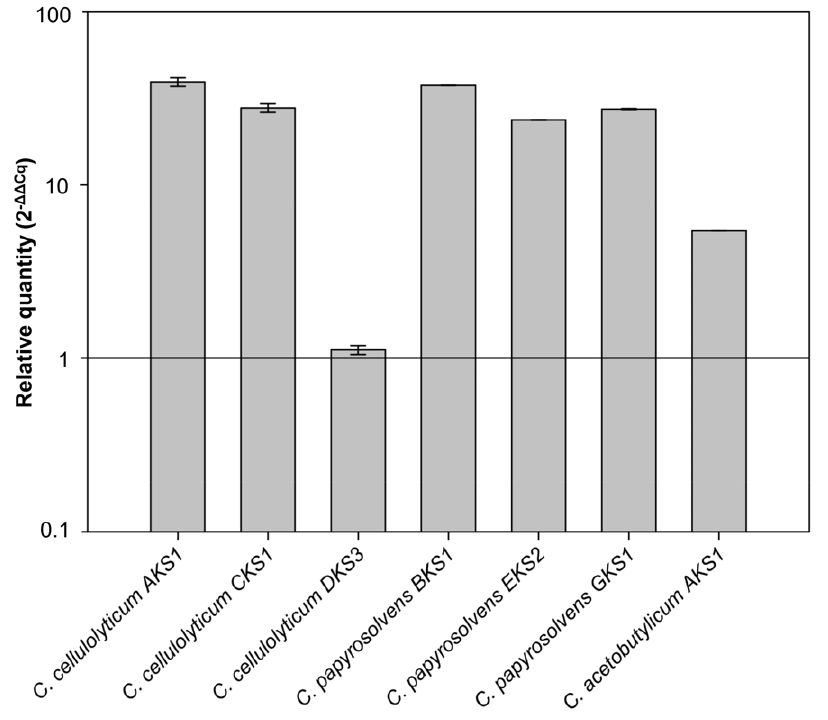
Figure 3. Relative quantity of the mRNA level determined by RT-qPCR of Clostridium species PKS genes (KS domains). Relative quantity is given as the log 2 of 2 DD Cq. Constitiutive expression of the 16S rRNA of each species was used as an internal control and the value of the related non template control of each sample was set to 1 for calibration.